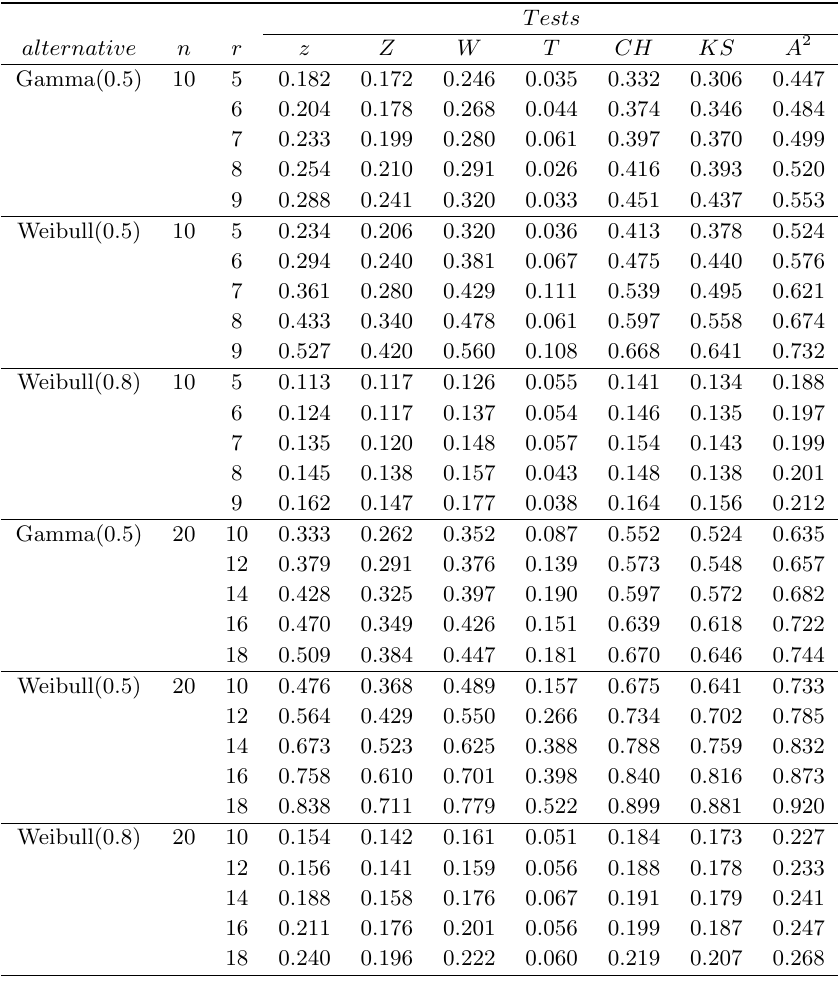
Power comparison at 10 % signi(cid:12)cance level: monotone decreasing hazard